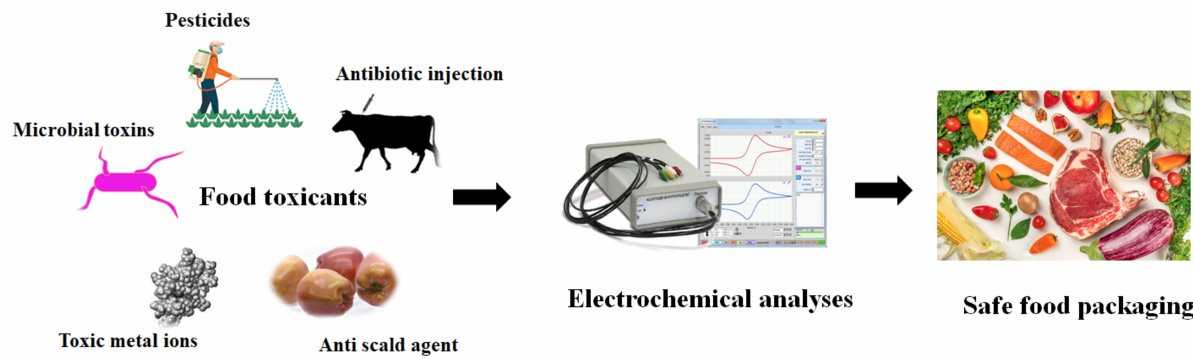
Figure 1. Ensuring food safety through electrochemical analyses of food toxic analytes from different sources has been shown